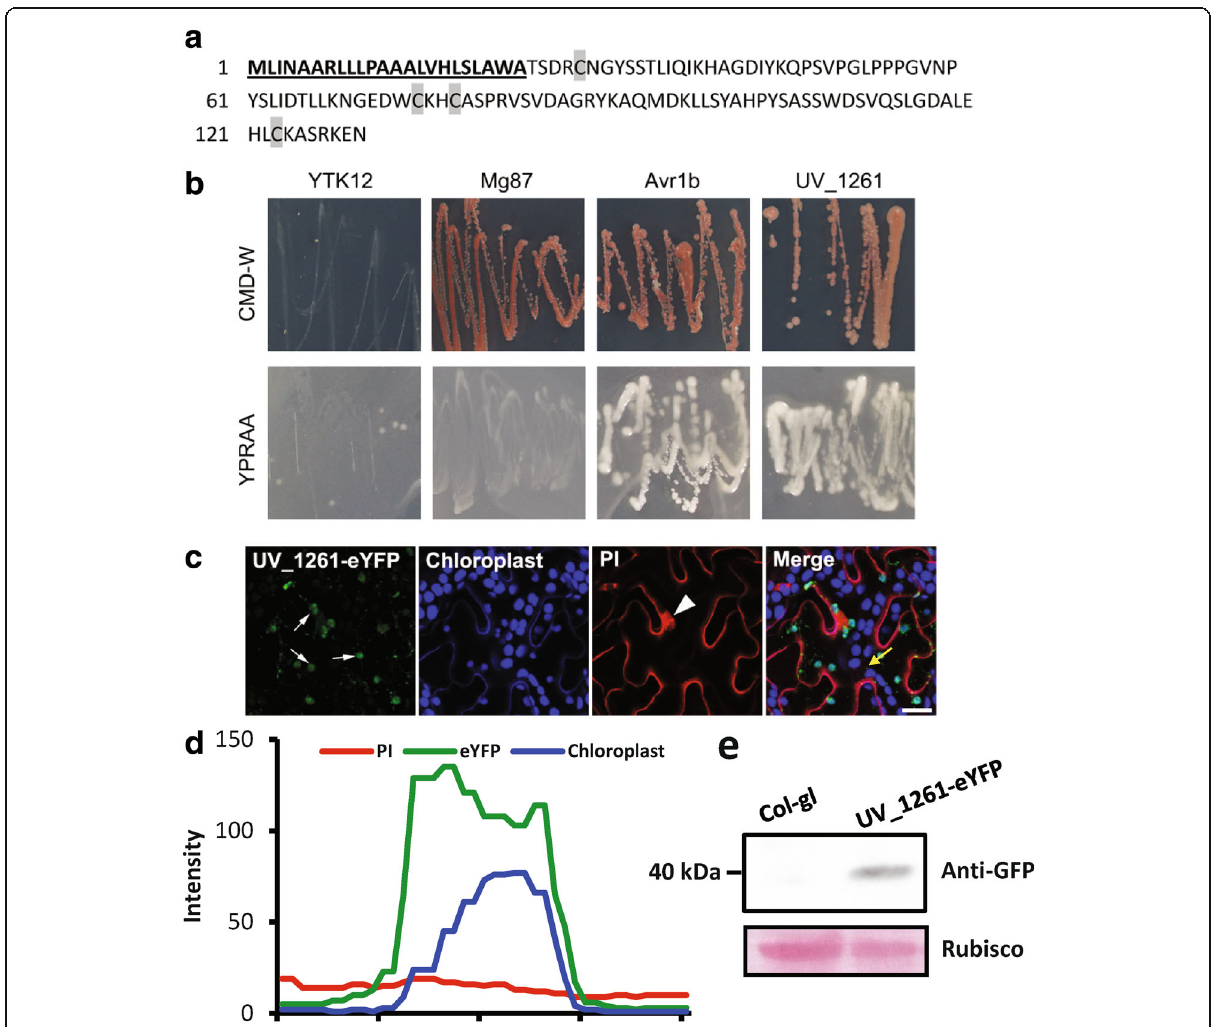
Fig. 2 Signal peptide validation and subcellular localization of UV_1261. a Protein sequence of UV_1261. Bold and underlined letters represent putative signal peptide. Shaded letters indicate cysteine residues. b Validation of UV_1261 signal peptide by yeast invertase secretion assay. Predicted signal peptide sequence of UV_1261 was fused in-frame to yeast mature invertase sequence in pSUC2 vector and expressed in YTK12. Functional signal peptide could enable yeast growth on both CMD-W and YPRAA. N-terminal sequence of Mg87 and signal peptide of Avr1b were used as the negative and positive control, respectively. c The construct UV_1261 - eYFP was transformed into Arabidopsis Col-gl. After obtaining T 2 transgenic lines, leaves expressing UV_1261-eYFP were checked under a confocal laser scanning microscope. Nuclei were stained by PI and false-colored in red. Chloroplasts showed autofluorescence and was false-colored in blue. White arrows point to chloroplasts, and white triangles point to nuclei. Scale bar, 20 μ m. d Fluorescence intensity curves were drawn according to the direction of the yellow arrow in ( c ). e Western blot with GFP antibody in Arabidopsis leaves expressing UV_1261 - eYFP . The band at 40 kDa indicates the UV_1261-eYFP fusion